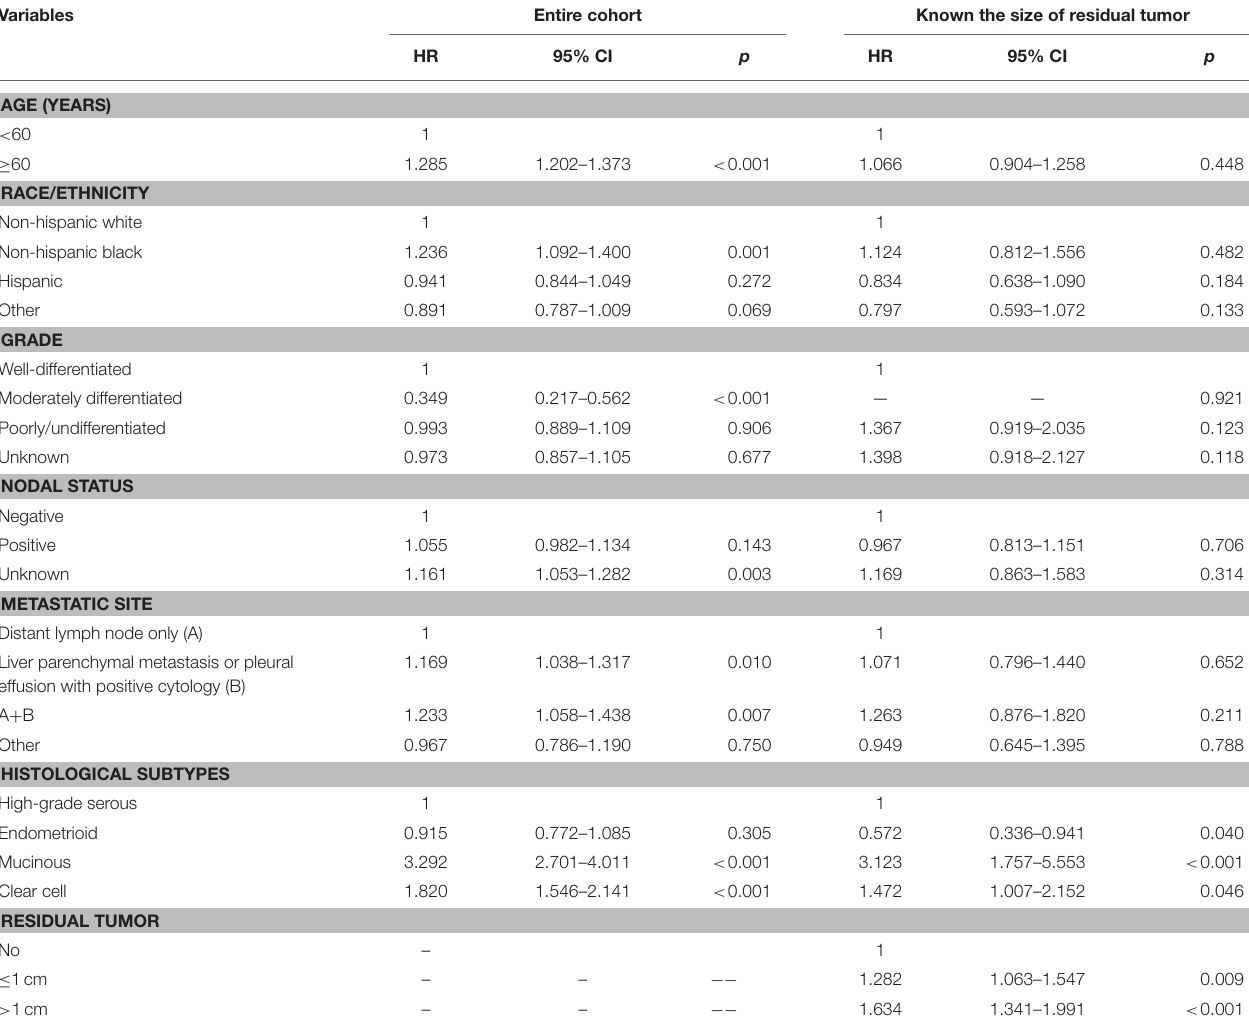
TABLE 2 | Multivariate prognostic